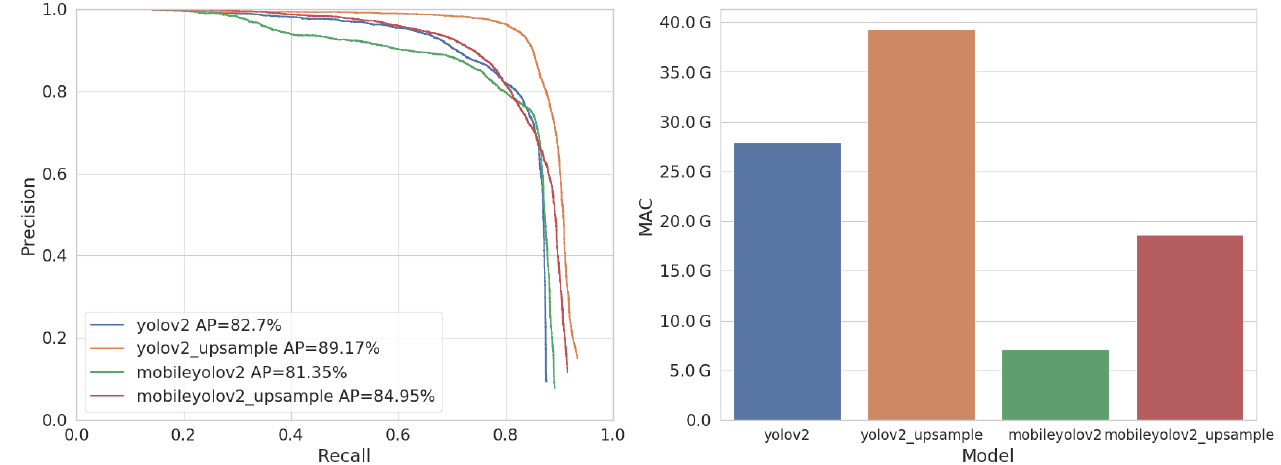
Figure 11. Accuracy (AP) and complexity (MAC) of our models on the LWIR Railway Surveillance validation